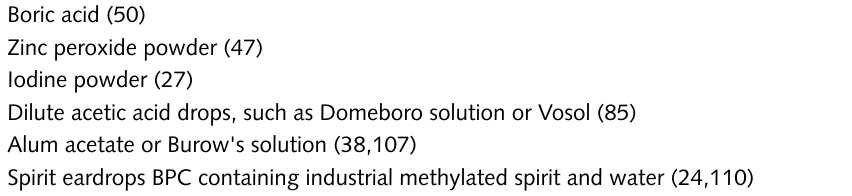
Table 10. Topical antiseptics, as reported in the literature Boric acid